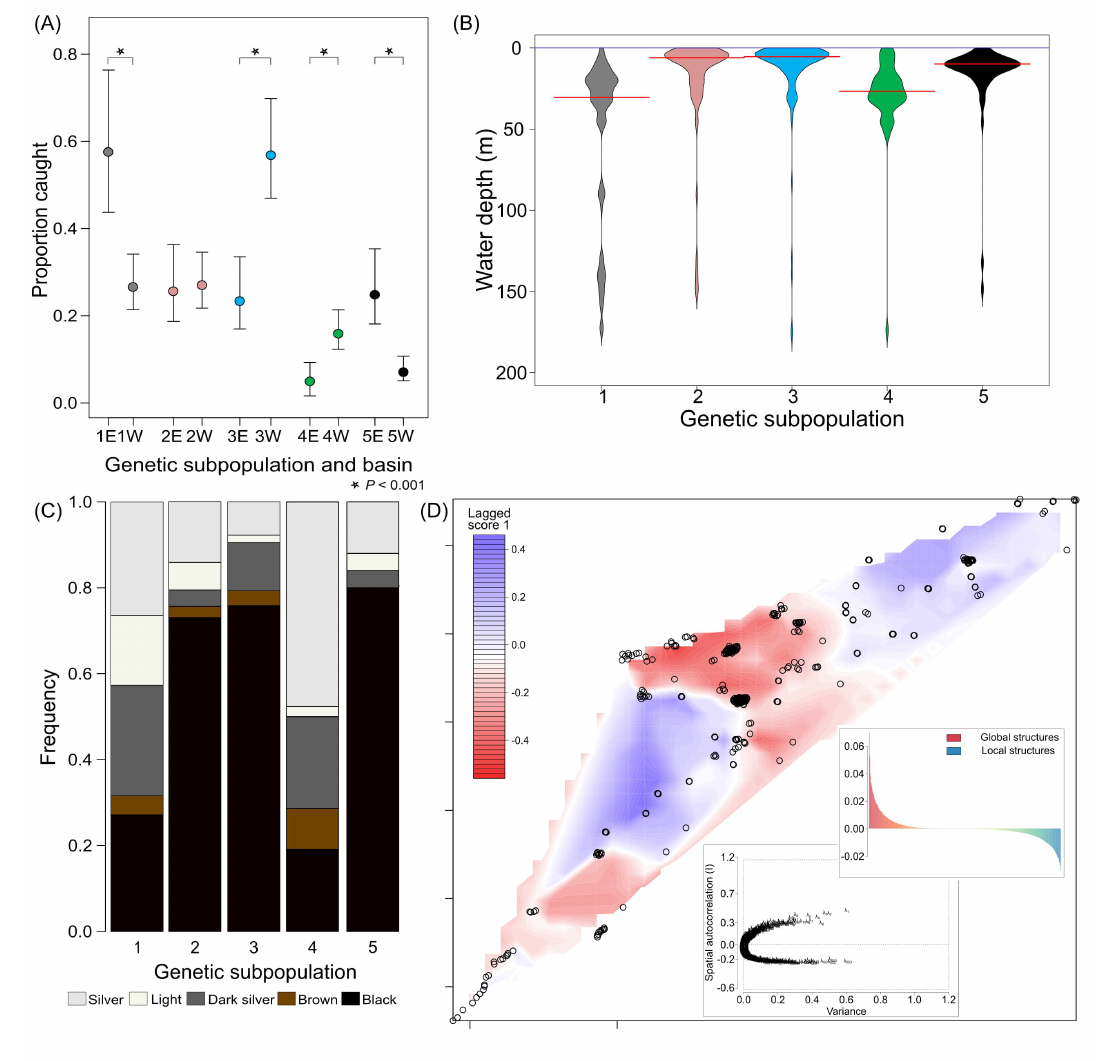
Fig. 2 . Findings from Marin et al. (2016) showing that genetically distinct subpopulations (A) 1 and 5 were captured in significantly greater numbers in the eastern basin, whereas subpopulations 3 and 4 were more predominant in the western basin; (B) subpopulation 1 was found in deep water, 4 was found mid-depth, and 2, 3, and 5 were captured in shallow water; (C) subpopulations 2, 3, and 5 were predominately black, whereas 1 and 4 were a mix of both dark and light coloration; (D) results of a spatial principal component analysis showing that individual lake trout are more closely related than by random chance in the western basin adjacent to the mouth of the Rupert River compared with those in the northern